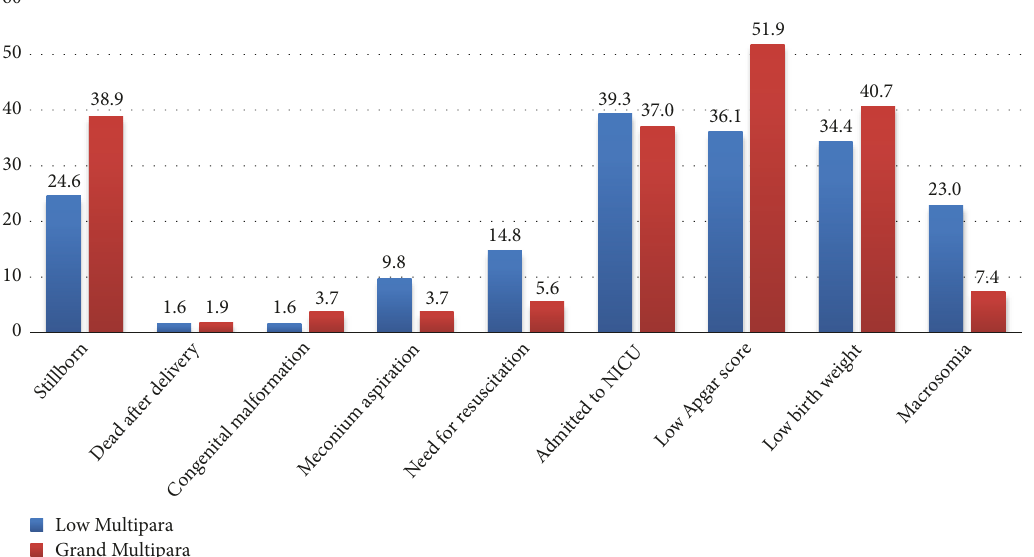
Figure 1: Adverse perinatal outcomes in Hawassa University Comprehensive Specialized Hospital & Adare General Hospital, 2018. Pearson’s p